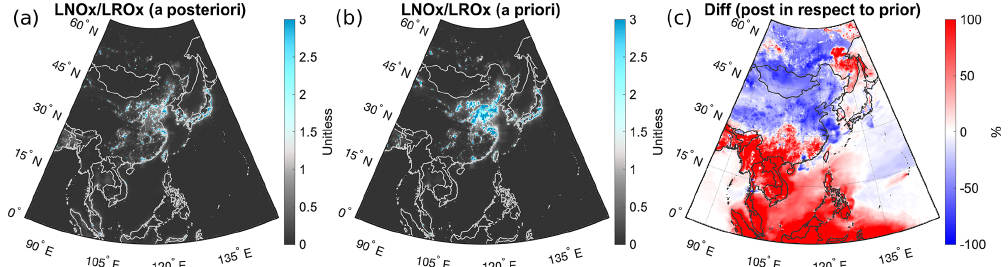
Figure 8. (a–c) Ratio of LNO x / LRO x simulated by the posterior emissions, the prior, and their relative differences at 12:00–18:00CST, averaged over May–June 2016 over the